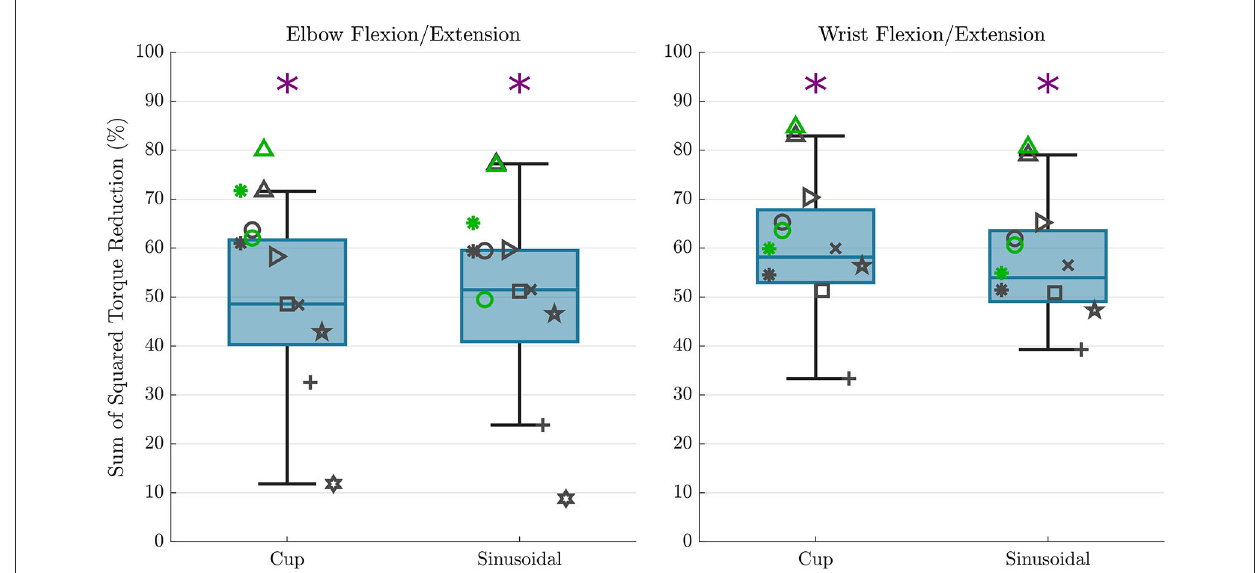
FIGURE6 Sum of squared torque reduction results are shown for all subjects for each trajectory for the elbow flexion/extension DOF (left) and wrist flexion/extension DOF (right) . The overlaid scatterplot shows individual subject results, with the same symbol representing a single subject across figures. Points in green show the repeated data collection for the first three subjects, but repeated data collection does not contribute to boxplot presentation. The purple “ ∗ ” above the plots represents a that there was a statistically significant difference in the sum of squared torque between the hybrid and exoskeleton alone control cases.